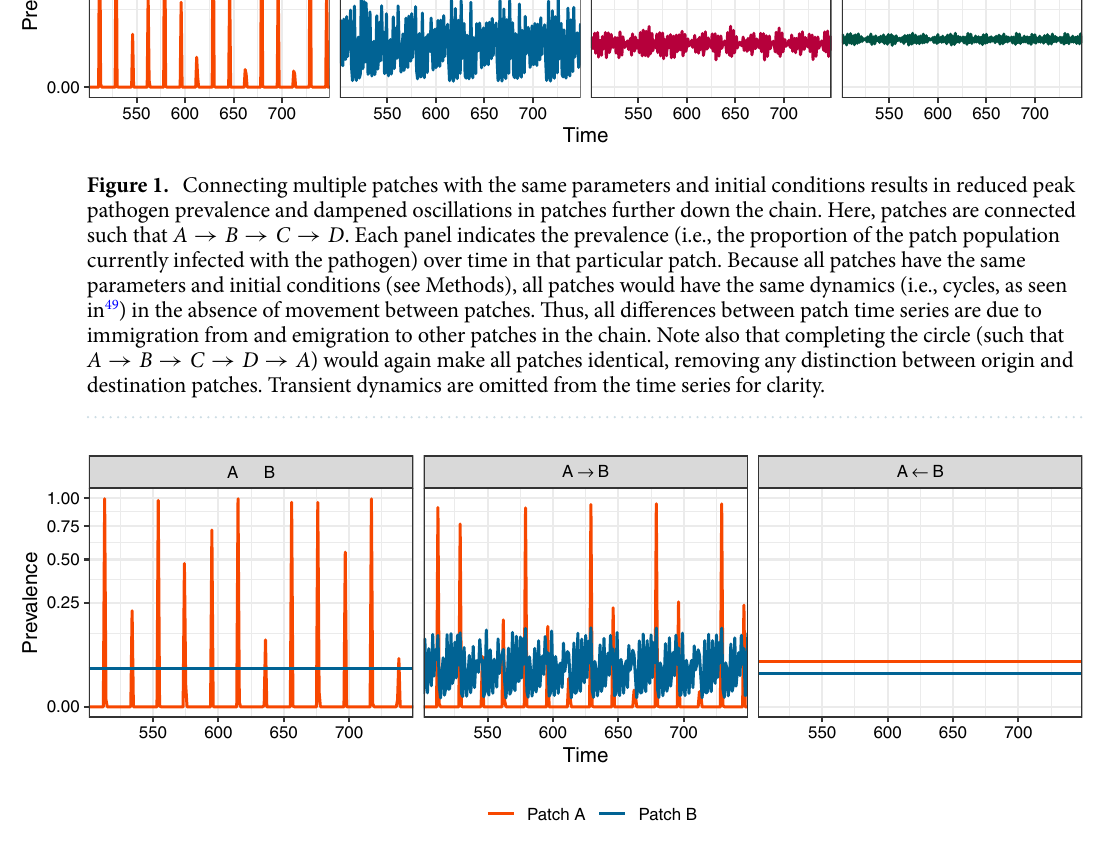
Figure 2. Destination patches tend to inherit origin patch dynamics when linking patches with different model parameterizations. Panels correspond to network structure, with line color indicating the prevalence (i.e., the proportion of the patch population currently infected with the pathogen) through time in particular patches. While in isolation (left column), patch A has oscillatory dynamics and patch B has steady-state dynamics (see Methods), when the two patches are linked by movement, the destination patch inherits the dynamics of the origin patch (center and right panels). This is true regardless of the direction of the movement (but does depend on the rate of movement; see Supporting Information Fig. S4). Transient dynamics are omitted from the time series for